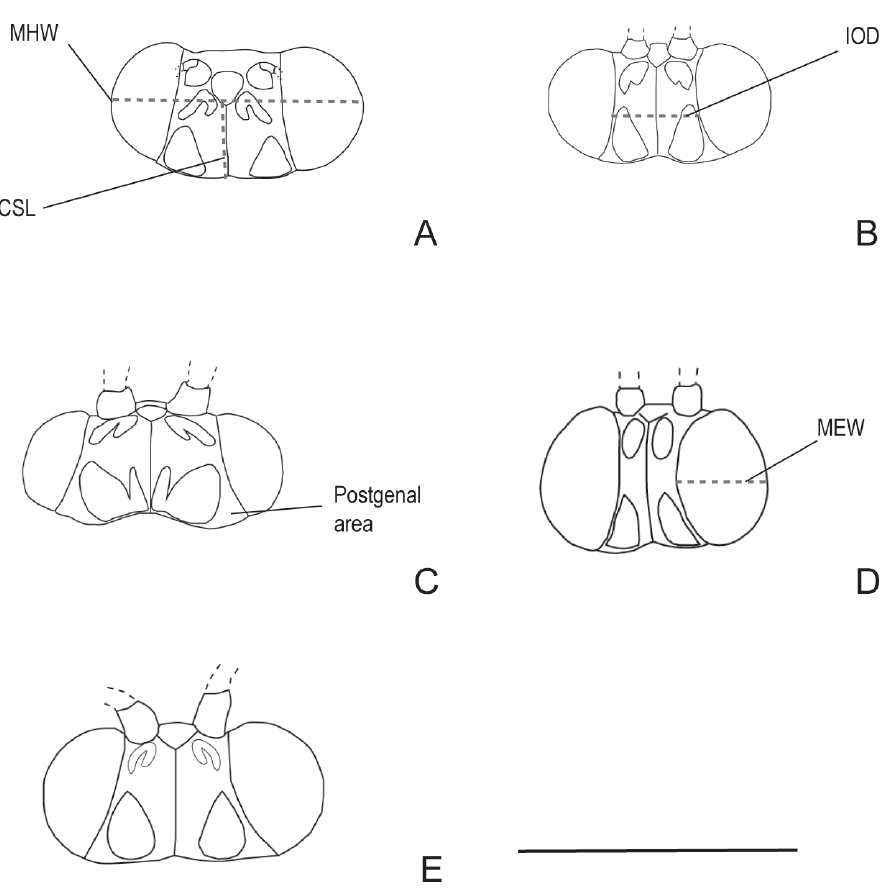
Figure 1. Heads in dorsal view of the species of the brasiliana group A Smicridea ( Rhyacophylax ) brasiliana B S. ( R .) weidneri C S . ( R .) vermiculata D S . ( R .) atrobasis E S. ( R .) nanda . Abbreviations: CSL length of the coronal suture, IOD interocular distance, MEW maximum eye width, MHW maximum head width. Scale bar: 1